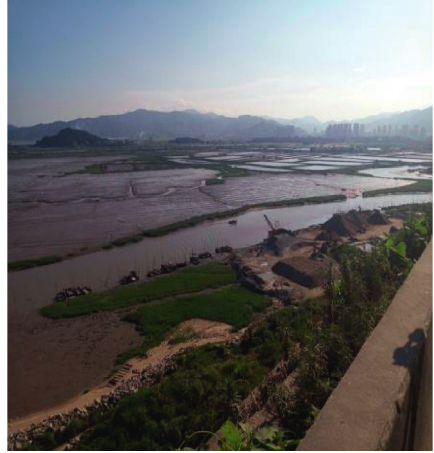
Figure 3: Tidal flat for case